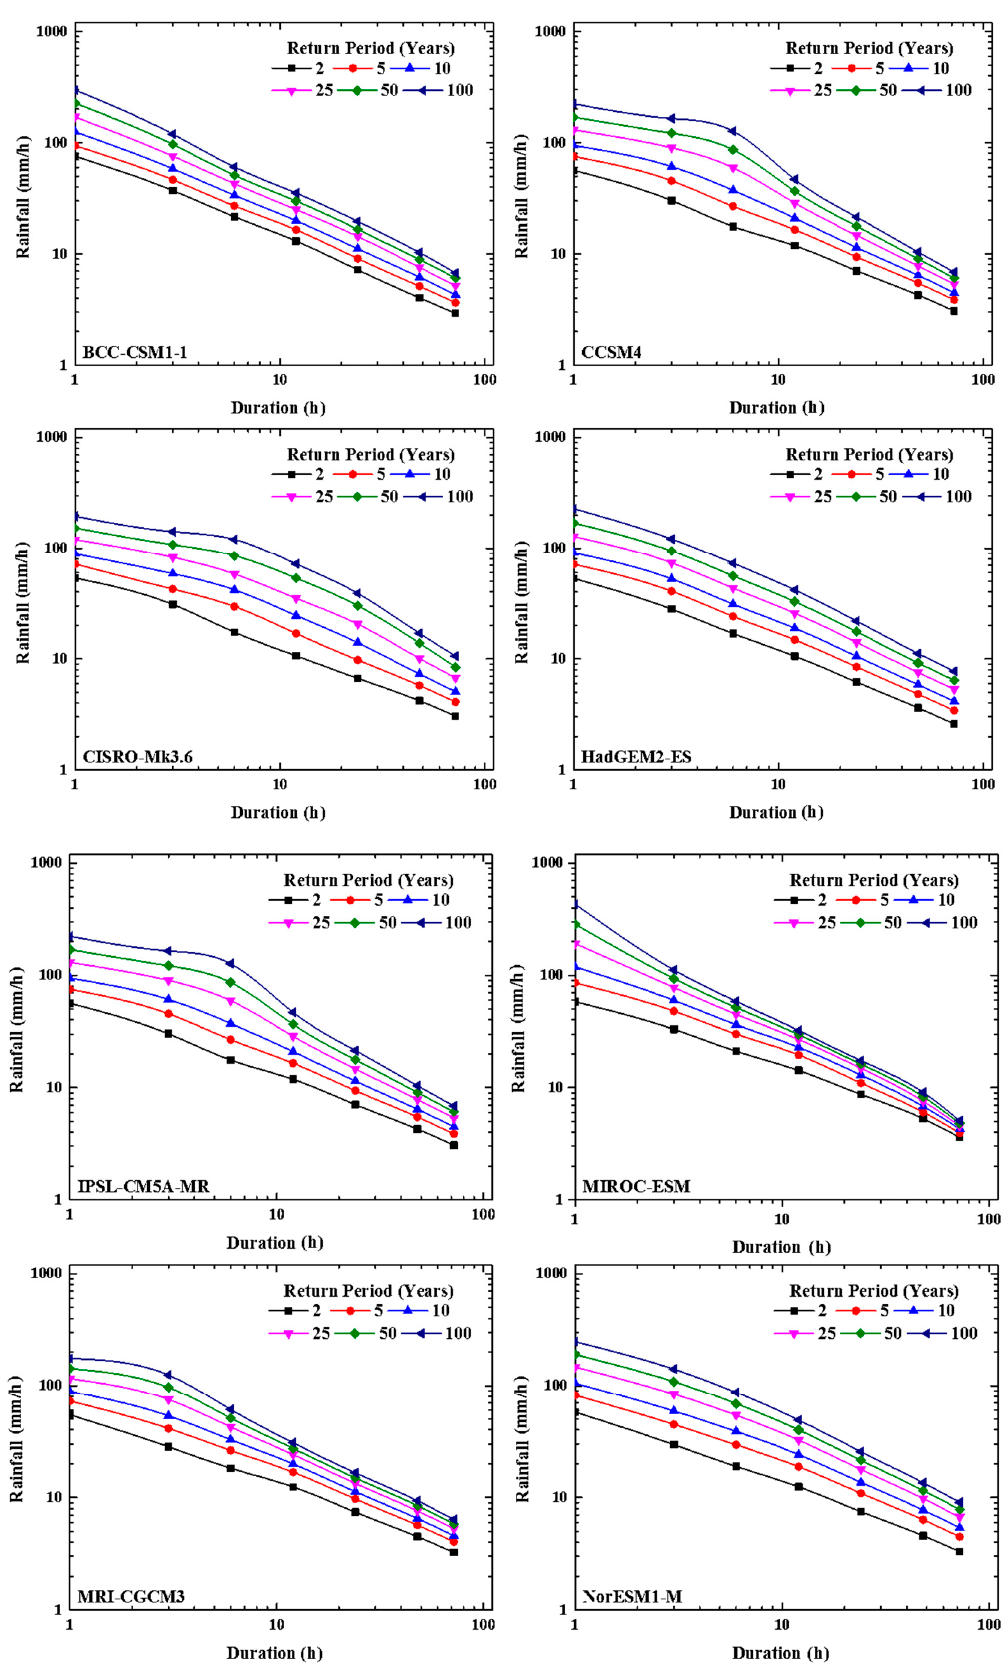
Figure 7. The IDF curves developed for station Kedah using GCMs projected rainfall data (2006–2099).